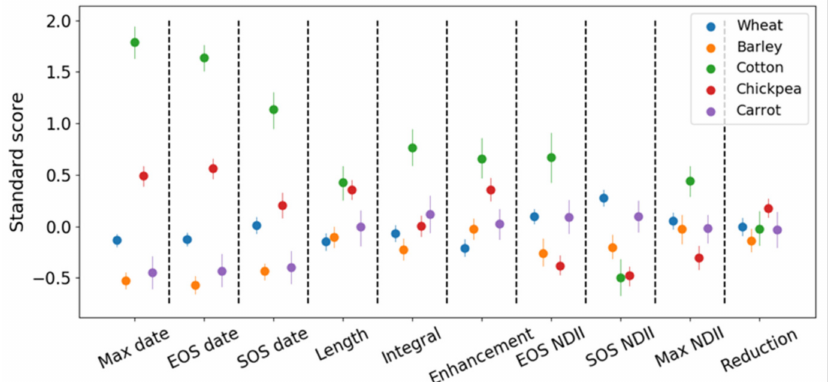
Figure 9. The mean standard score of each crop for each one of the features. The error bars represent the confidence interval. Max date, EOS date, SOS date, Max NDII, EOS NDII, and SOS DNII refer to the dates when NDII value was at the maximum, the date when the growing season had started, the date when the growing season had ended, and the corresponding NDII values at theses dates, respectively. Length references the length of the growing season. Integral references the seasonal integral. Enhancement and Reduction refer to the enhancement and reduction periods.